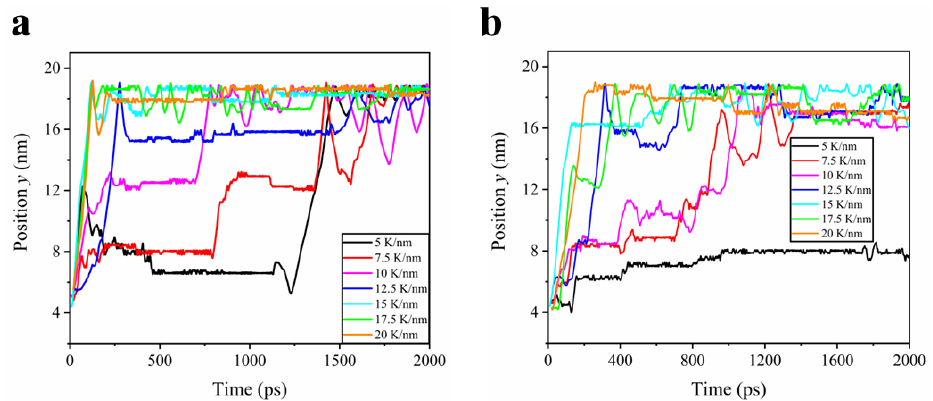
Figure 6. The movements of graphene nanoflakes along y direction for ( a ) pristine and ( b ) hydrogen- passivated graphene under various thermal gradients from 5 K/nm to 20 K/nm.